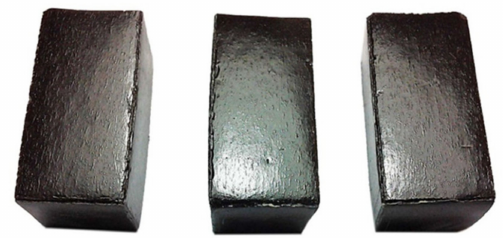
Figure 3. Specimens for the compressive strength test.